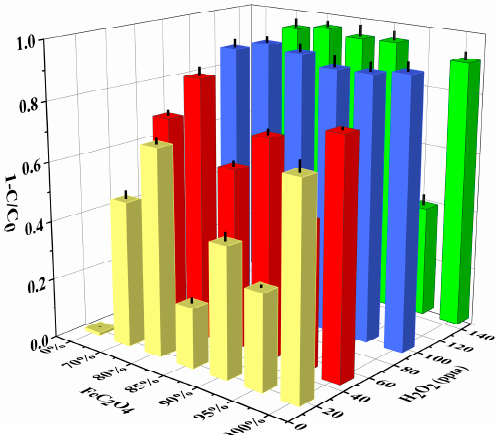
Figure 6. Effects of FeC 2 O 4 content and H 2 O 2 concentration on degradation performance.